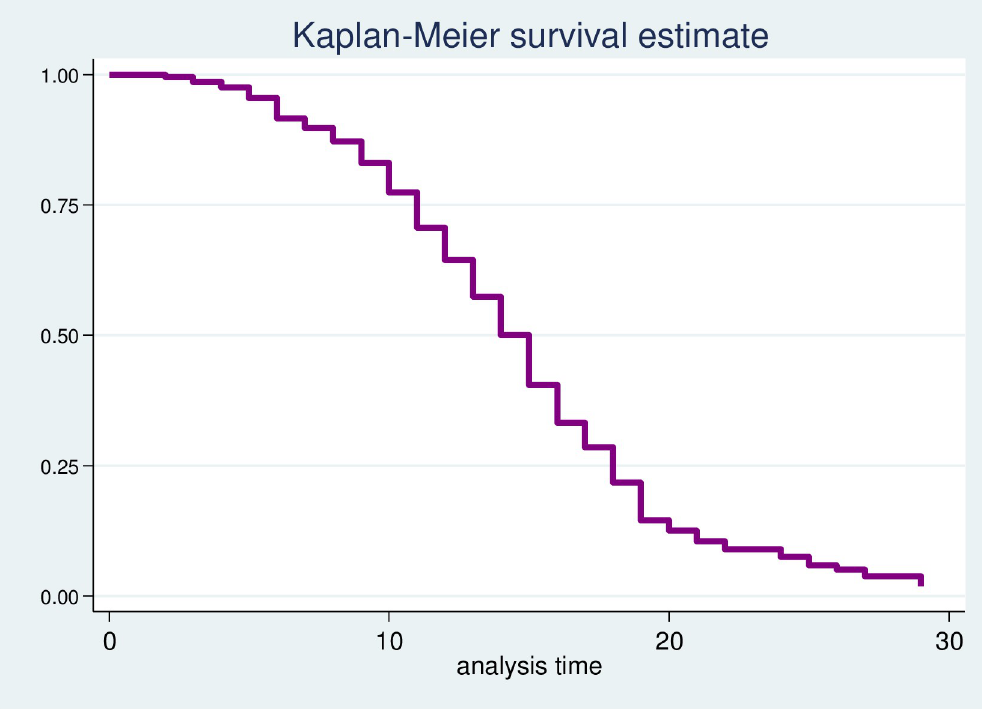
Fig 2. Kaplan-Meier survival function estimates of children with severe acute malnutrition at Asosa general hospital, 2015–2019.